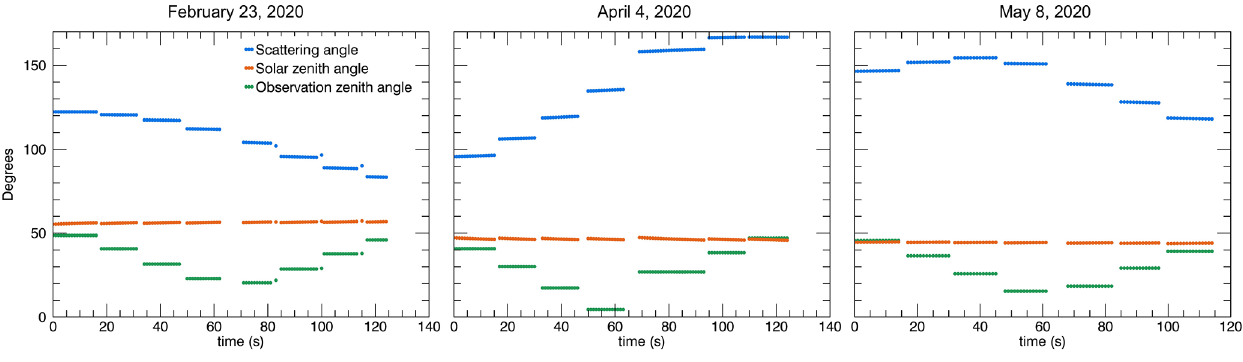
Figure 11. Geometry data for the three simulated Australian desert SAMs.